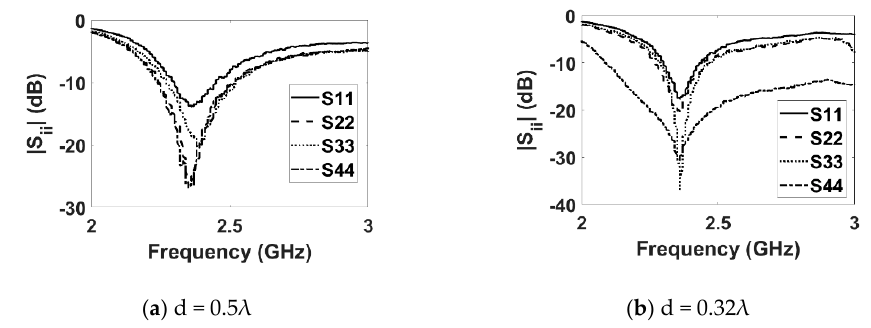
Figure 6. Measured reflection coefficient (H plane). Table 1. Measured E-plane coupling coefficients (|Sij|)